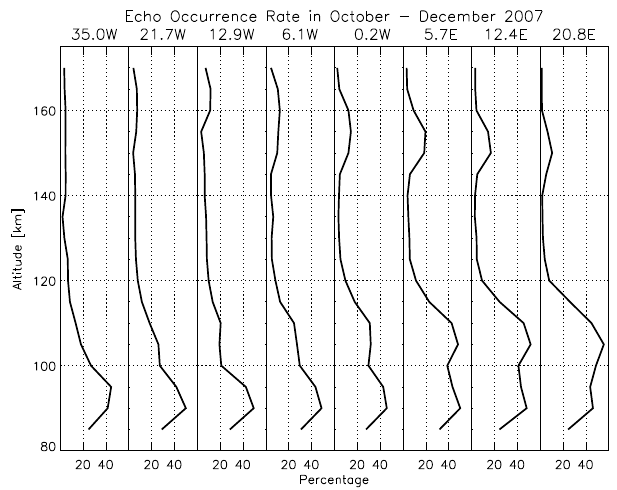
Fig. 7. Occurrence rates of radar echoes of over − 6 dB between 09:00 LT and 15:00 LT in each direction for 13 days during the normal mode observation.